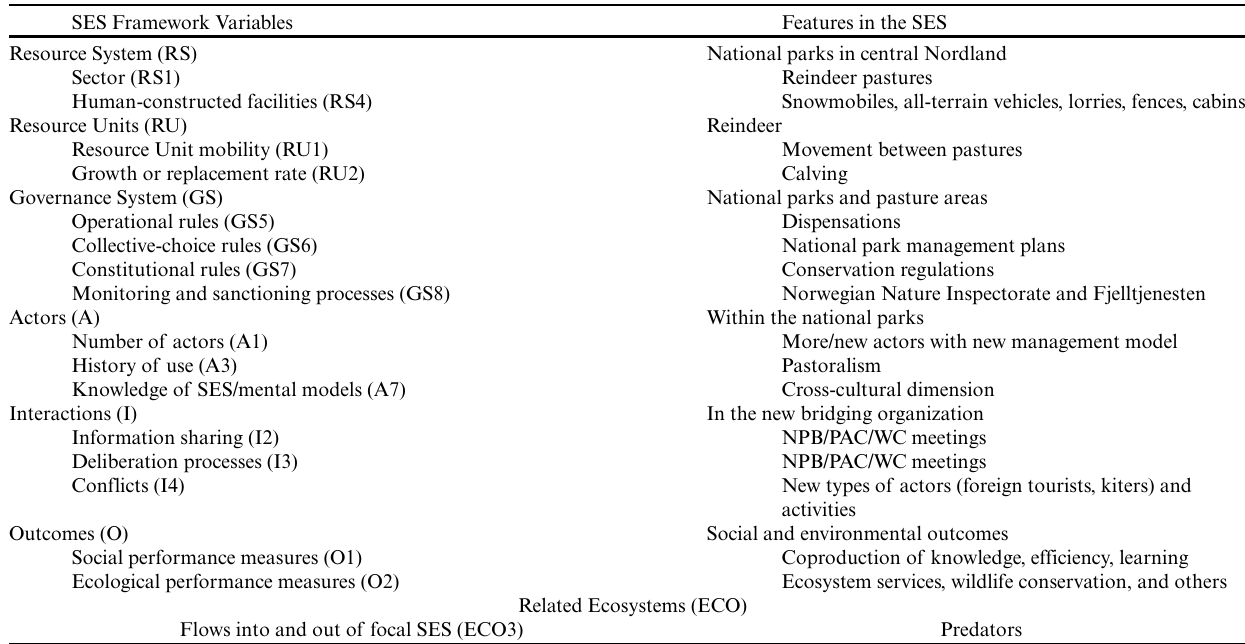
Table 1 . Second tier variables important for the analysis of national parks as social-ecological system (SESs). (NPB: National Park Board; PAC: Professional Advisory Committee; WC: Working